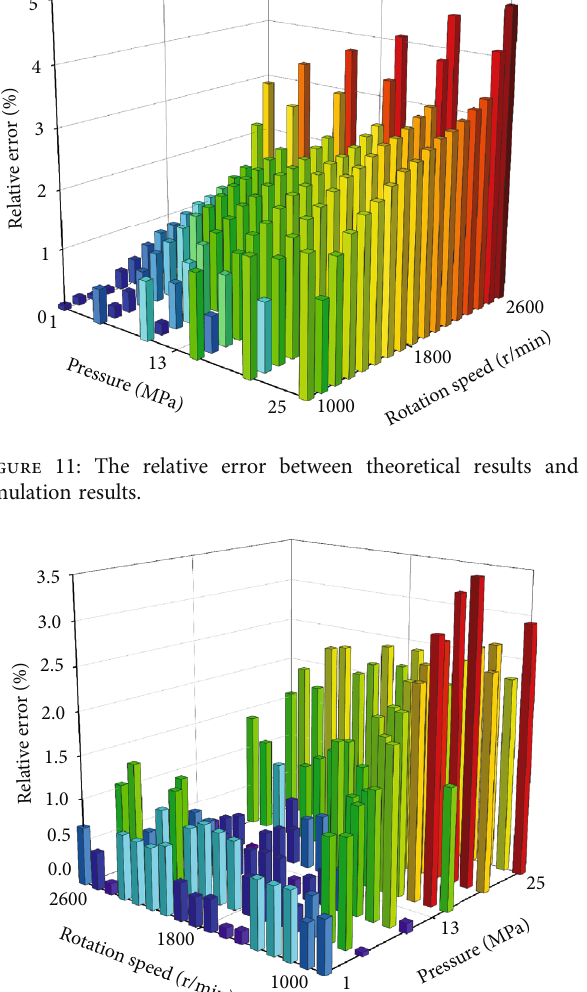
Table 3: Combination list of distribution circle radius and rotation speed.